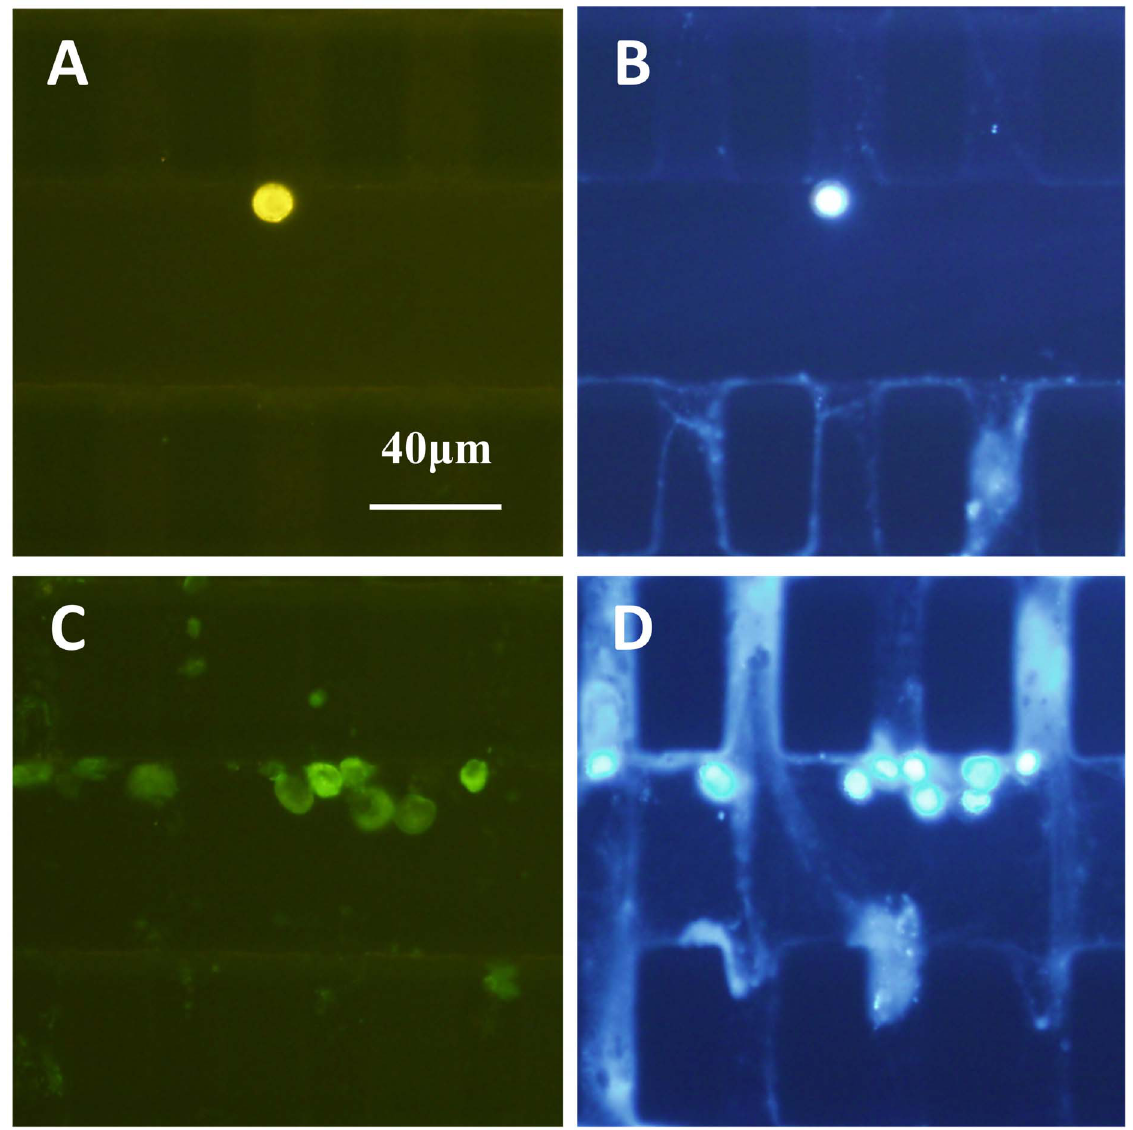
Figure 3. Circulating tumor cells and normal blood cells in one typical patient with rectal cancer. A/B: CTCs staining; C/D: normal blood cells staining. A) positive CK staining in CTCs; B) positive DAPI staining in CTCs; C) positive CD45 staining in normal blood cells; D) positive DAPI staining in normal blood cells.